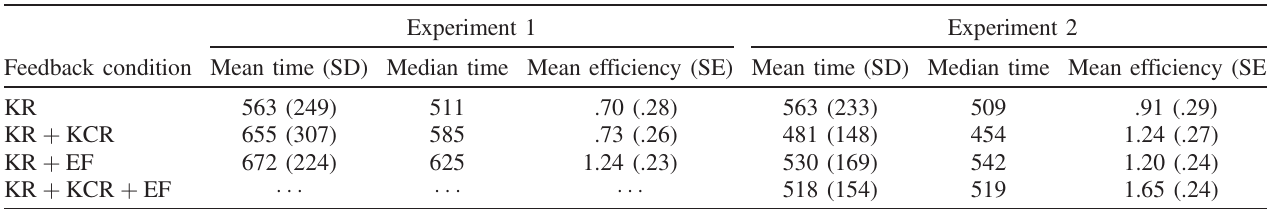
TABLE IV. Mean and median total training times and mean efficiencies for each condition in each experiment. Times are listed in